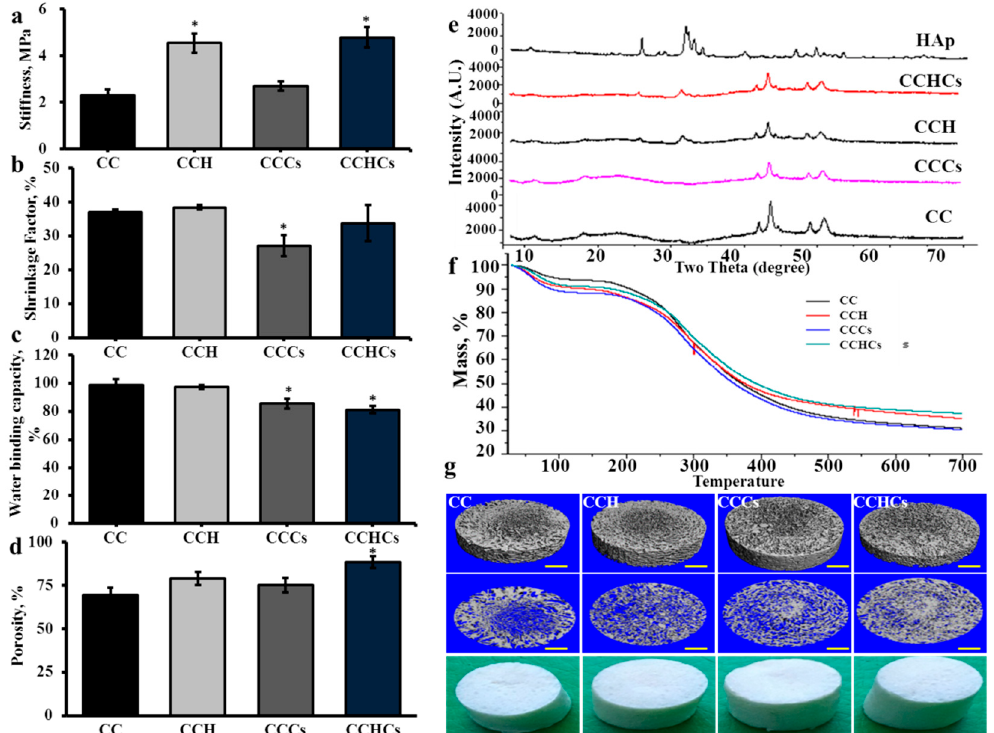
Figure 2. Rheological properties of chitosan-collagen-based bio-mimic three-dimensional (3D) matrices. Stiffness ( a ), shrinkage factor ( b ), water binding capacity ( c ), porosity ( d ), XRD spectra ( e ), TGA spectra ( f ), and micro-CT images ( g ) of chitosan-collagen-based bio-mimic 3D matrices. CC: chitosan-collagen 3D matrix, CCH: chitosan-collagen-hydroxyapatite 3D matrix, CCCs: chitosan-collagen-chondroitin sulfate 3D matrix and CCHCs: chitosan-collagen-hydroxyapatite-chondroitin sulfate 3D matrix. The experiments were done three times with similar results. * p < 0.05 vs. CC 3D matrix.